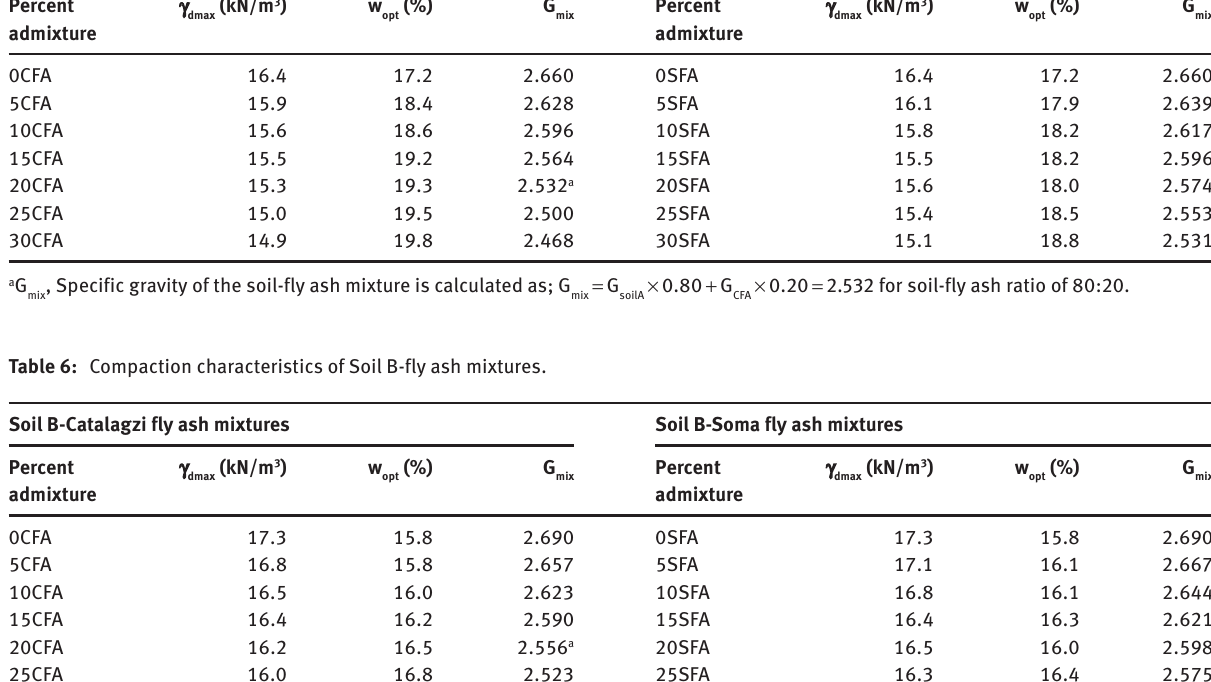
Table 5: Compaction characteristics of Soil A-fly ash mixtures. Soil A-Catalagzi fly ash mixtures